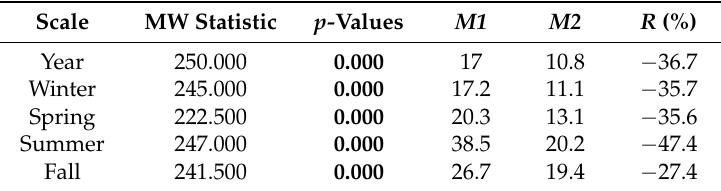
Table 1. Comparison of mean values of annual and seasonal minimum daily flows before (1980–2002) and after (2004–2014) construction of the diversion dam using the Kruskal-Wallis test. Monitoring